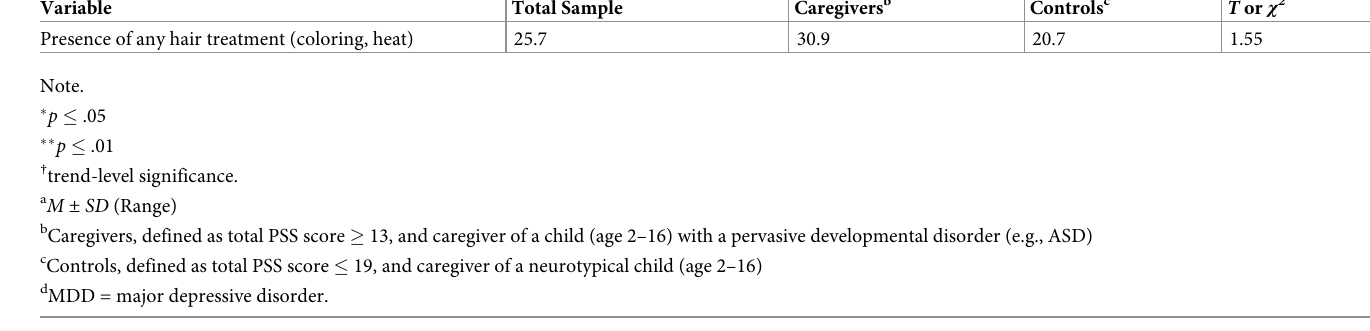
proximal segment ( F (1,163) = 6.81, p = .01) and distal segment of hair cortisol level ( F (1,154) = 4.65, p = .03). We observed an identical pattern of findings when examining hair cortisol at the 2 year assessment, such that caregivers ( n = 51) had significantly lower levels of hair corti- sol (proximal: 26.91 ± 6.76 pg/mg; distal: 9.33 ± 13.49 pg/mg) compared to controls ( n = 57; proximal: 89.13 ± 13.80 pg/mg; distal: 54.95 ± 35.48 pg/mg). Indeed, there was a main effect of group for both 2 year proximal segment ( F (1,105) = 7.58, p = .007) and distal segment of hair cortisol level ( F (1,102) = 9.33, p = .03; Fig 1). In prospective analyses, caregivers did not differ from controls with regard to change in proximal hair cortisol ( p = .76; Table 2, top panel). On average, caregivers decreased in proxi- mal hair cortisol from baseline to 2 years by 0.95 pg/mg, whereas controls increased in proxi- mal hair cortisol by 1.12 pg/mg, however, these group differences were not statistically significant. Further, when including intervention status in the model, we found no main effect of group, intervention status, or group X intervention status interaction ( ps > .48). Further- more, in prospective analyses, caregivers did not differ from controls with regard to change in distal hair cortisol ( p = .50; Table 2, bottom panel), although there was an average decrease observed among caregivers of 0.90 pg/mg whereas controls evidenced an average increase of 1.56 pg/mg over the 2 years. When including intervention status in the model, we found no main effect of group, intervention status, or group X intervention status interaction ( ps > .60).